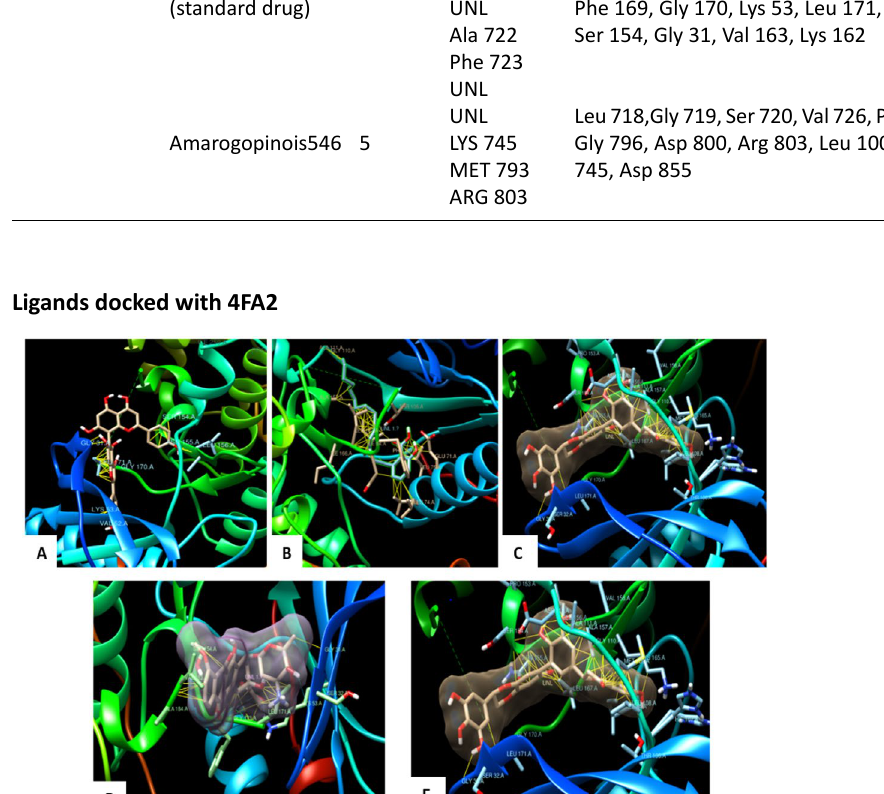
Fig. 4. Docked pose of the ligand shown with p38α MAP kinase protein and Hydrophobic interactions displayed within the solid surface of the docked complex between the binding residues of the p38α MAP kinase receptor and the small molecule A: Agasthisflavone, B: Anacardic acid, C: Zoapatanolide A, D: Doxorubicin and E: Amarogopinois546.